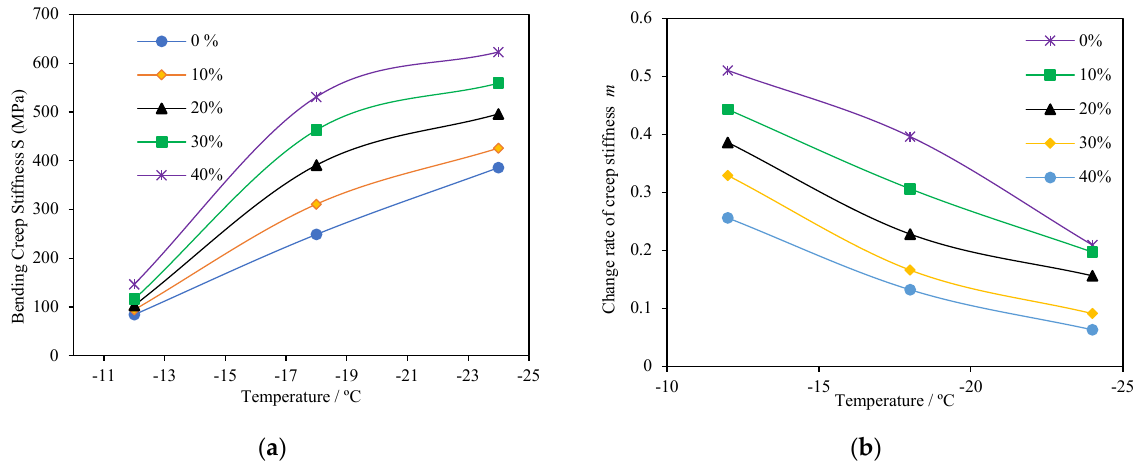
Figure 9. Low-temperature properties of asphalt with different PCB-NMF contents; ( a ) creep stiffness; ( b ) change rate of creep stiffness.